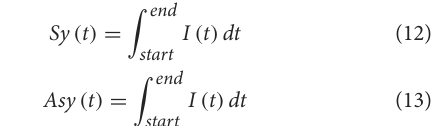
dynamic transmission power parameters in Beijing, Dalian, Xinjiang and Guangzhou were 1.15:0.25, 1.30:0.20, 0.48:0.32, and 0.55:0.31, respectively. It was shown that the initial dynamic transmission power parameters were lasrger for asymptomatic infections than for symptomatic infections. Furthermore, larger initial transmission power parameters predicted stronger subsequent outbreaks. Under effective control measures, the dynamic transmission power parameter would keep decreasing, and when the dynamic transmission power parameter equaled zero, it indicated the end of the outbreak. infections were represented by Equations (12) and (13),